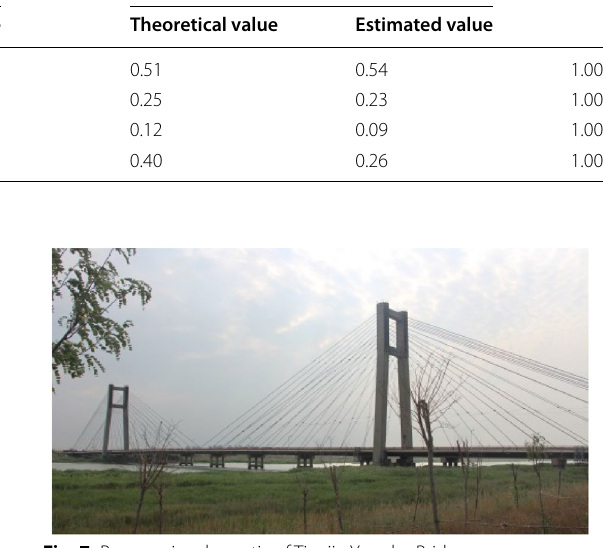
Fig. 7 Panoramic schematic of Tianjin Yonghe